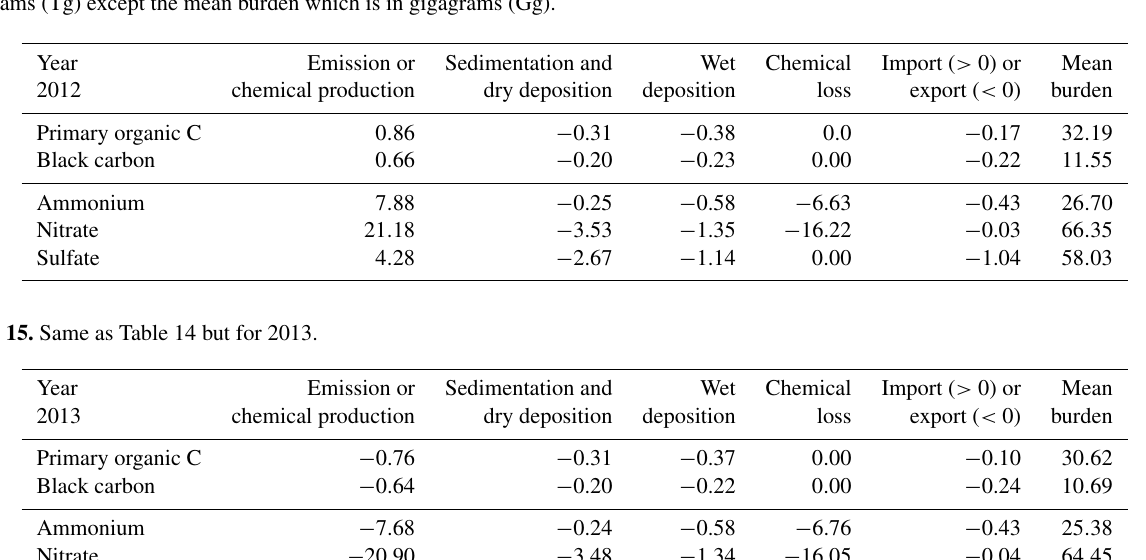
Table 14. Annual budget for the year 2012 of the total mass of aerosols for the sensitivity test simulation. The different components are in teragrams (Tg) except the mean burden which is in gigagrams (Gg).